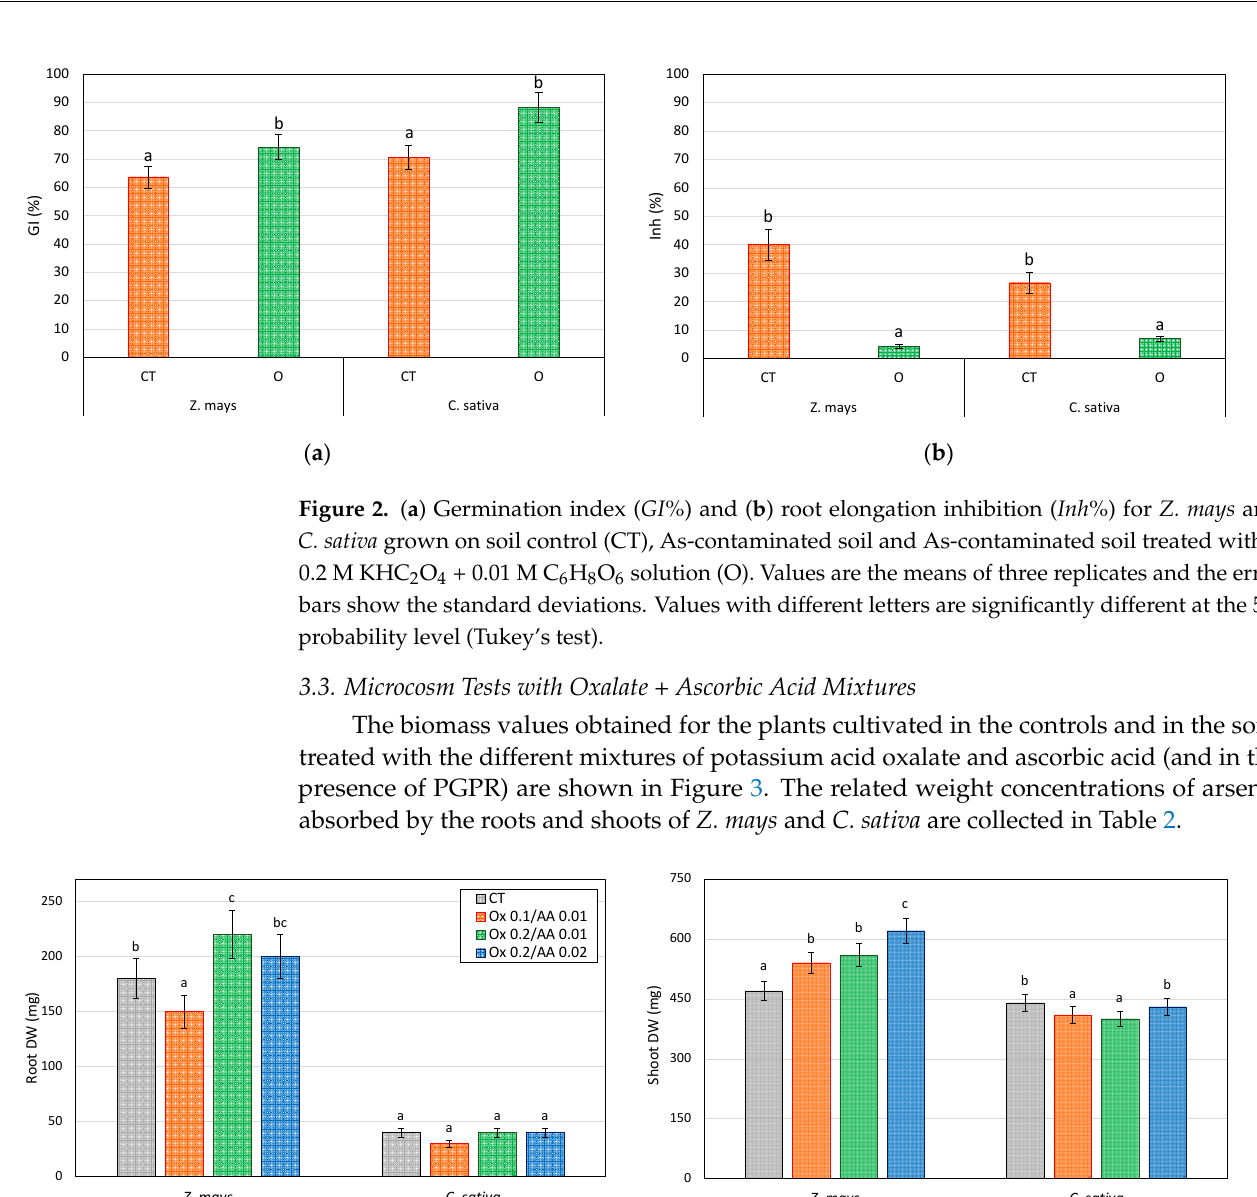
Figure 3. Dry weights (mg pot − 1 ) of ( a ) roots and ( b ) shoots of Z. mays and C. sativa grown on soil control (CT) and As-contaminated soils treated with the different mixtures of oxalate and ascorbic acid (microcosm tests). Values are the means of three replicates and the error bars show the standard deviations. Values with different letters are significantly different at the 5% probability level (Tukey’s test).